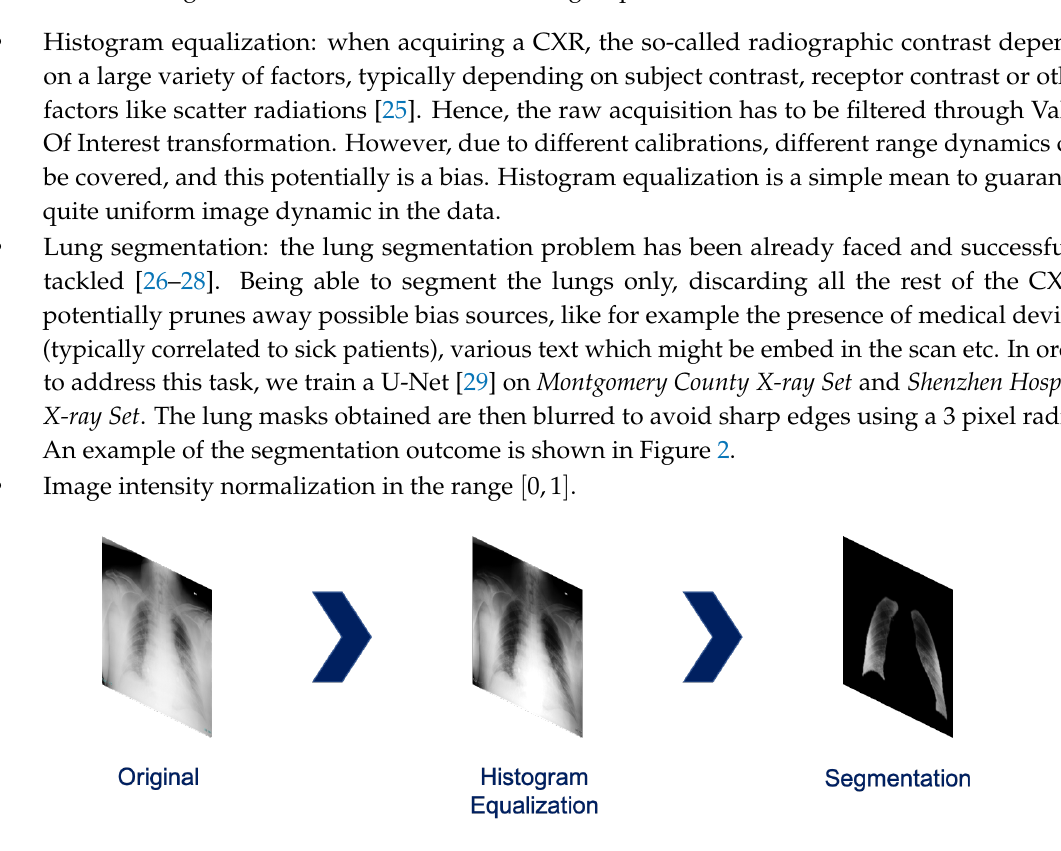
Figure 1. CXR pre-processing steps